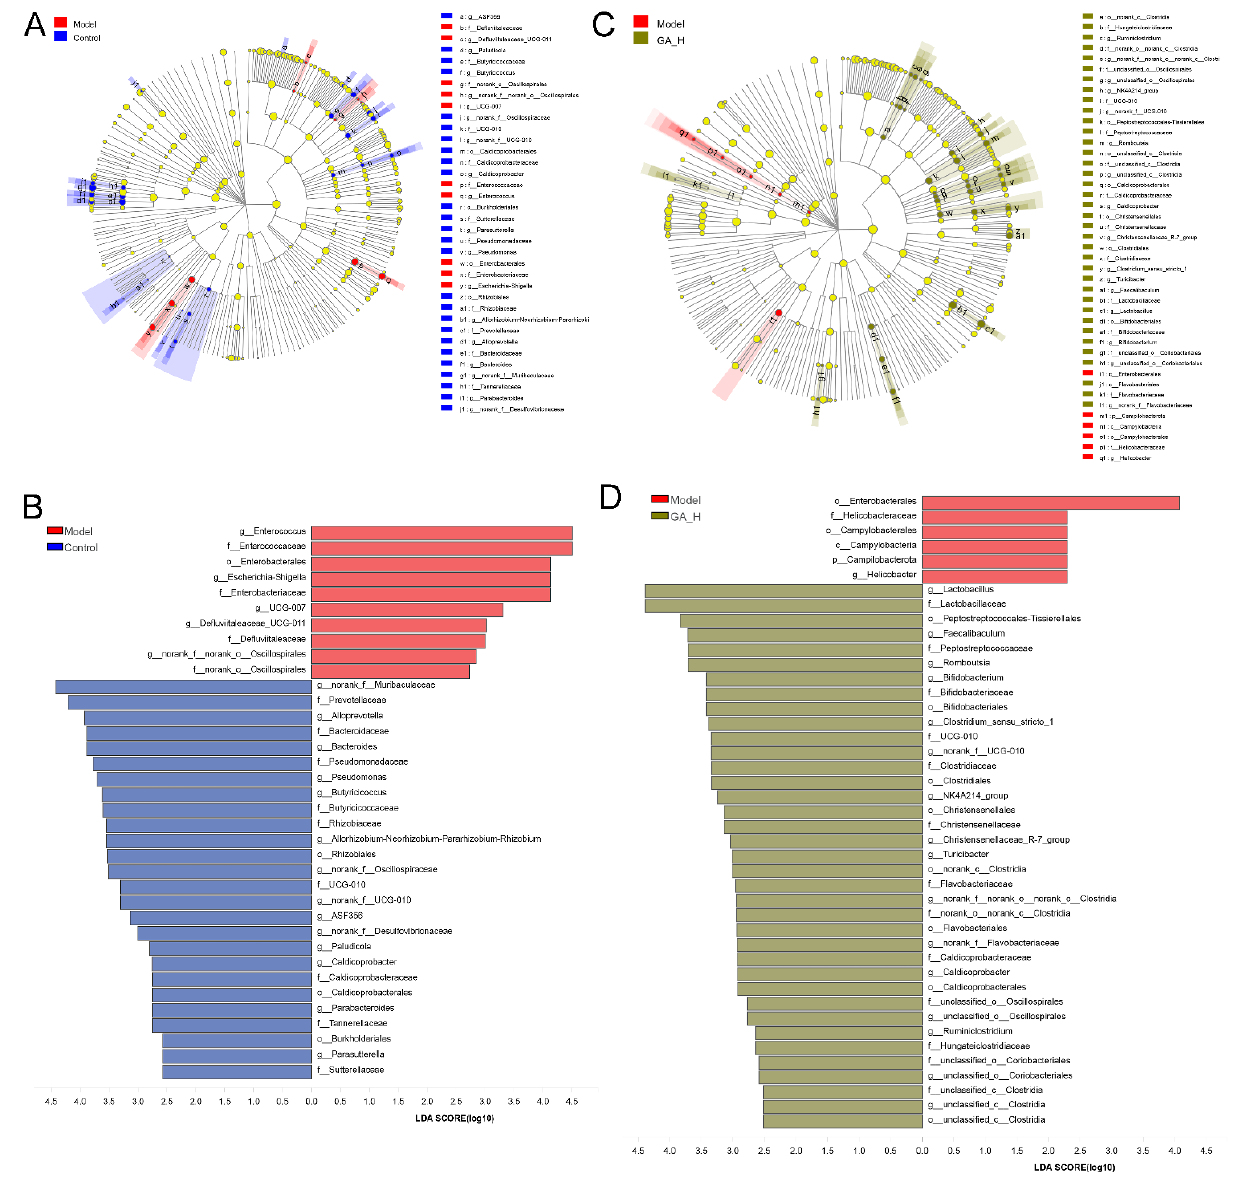
Figure 5. Characterization of microbiomes in mice of the control, model and GA-H groups by the linear discriminant analysis (LDA) effect size (LEfSe) method. ( A , B ) Taxonomic representation of statistically and biologically consistent differences in mice of the control, model and GA-H groups. ( C , D ) Histogram of the LDA scores (log10) calculated for features with differential abundance in mice of the control, model and GA-H groups.